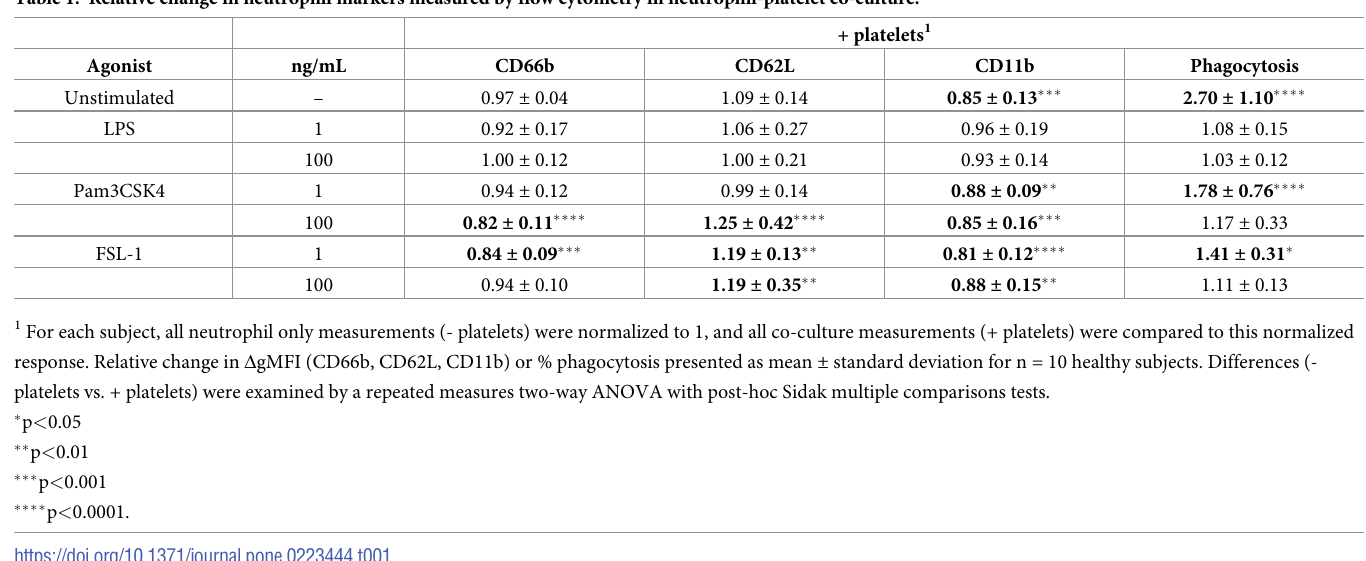
Table). In this study, phagocytosis was defined as the percentage of neutrophils that were posi- tive for FITC fluorescence, indicating internalization of latex beads conjugated to FITC that were added to all neutrophil cultures. In unstimulated cultures, the percentage of neutrophils that were positive for phagocytosis was 2.7-fold higher with the addition of platelets, compared to neutrophils alone (p < 0.0001, Fig 6B, Table 1). Platelet co-culture also resulted in a higher rate of phagocytosis seen in response to low-dose Pam3CSK4 (1.78-fold higher) and low-dose FSL-1 (1.41-fold higher, both p < 0.05, Fig 6B).